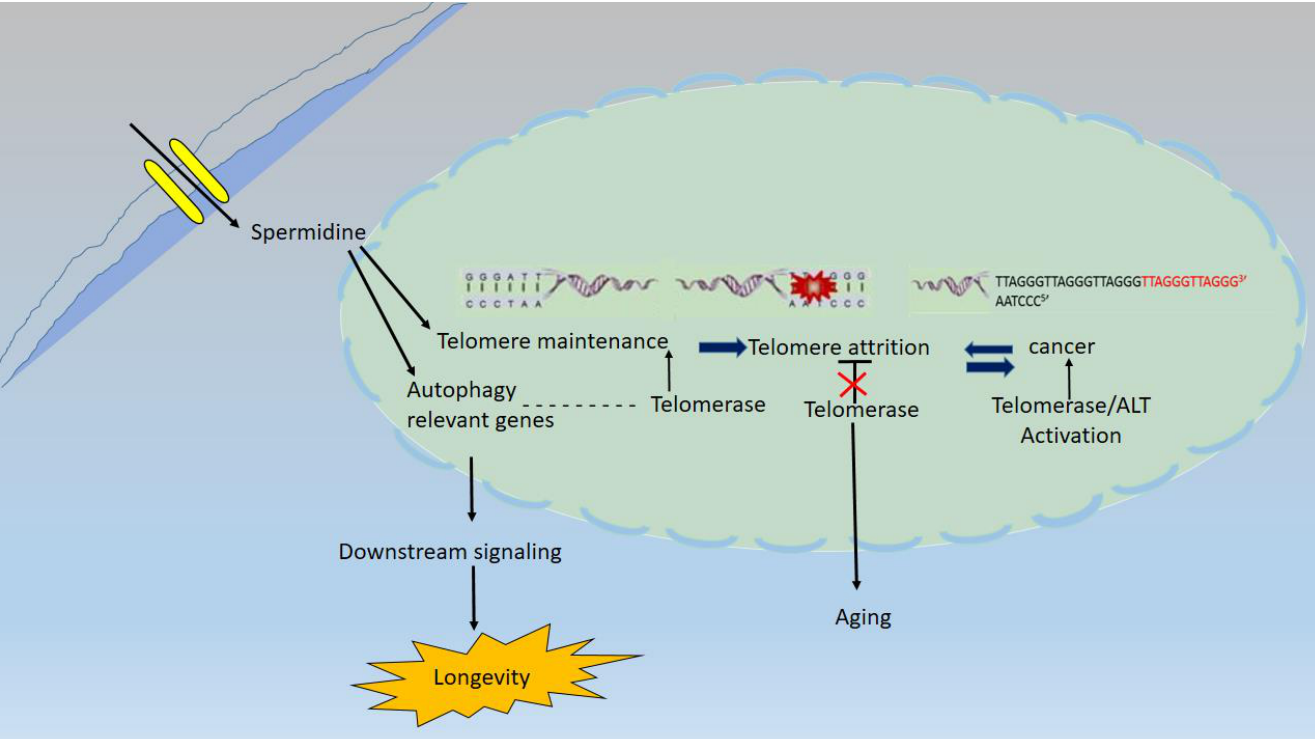
Fig. 2. A schematic representation of experimental strategy and expected outcome considering if spermidine is positively regulating the expression of